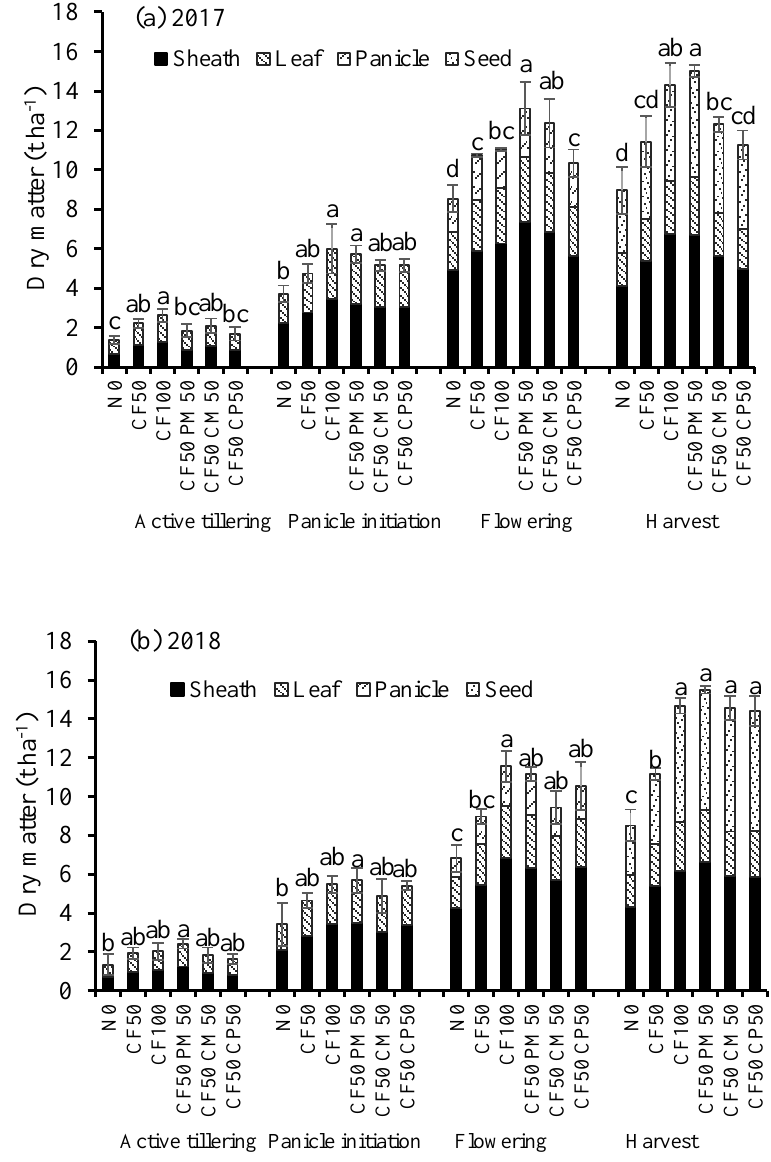
Figure 4. Dry matter (t ha − 1 ) of rice variety Manawthukha a ff ected by organic fertilizers at the critical growth stages. The histograms with the same letter in the same case at each stage are not significantly di ff erent by the Tukey honestly significant di ff erence (HSD) test ( p < 0.05). Vertical bars represent the SD of three samples.